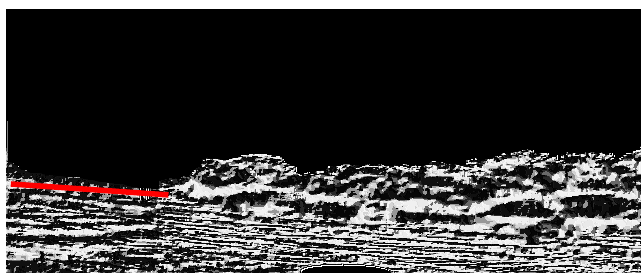
Figure 11. The reference line for local searching.